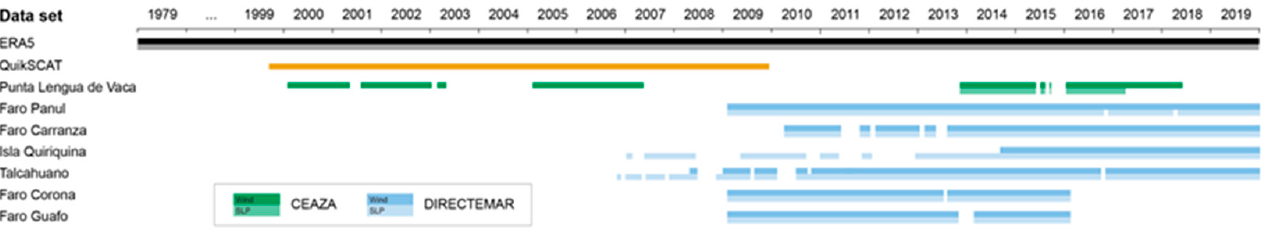
Figure 3. Periods of measurements at different meteorological stations for V a (light) and SLP (dark). The data obtained from CEAZA is presented in green, the data facilitated by DIRECTEMAR in blue, the ERA5 reanalysis in black and QuikSCAT in orange.